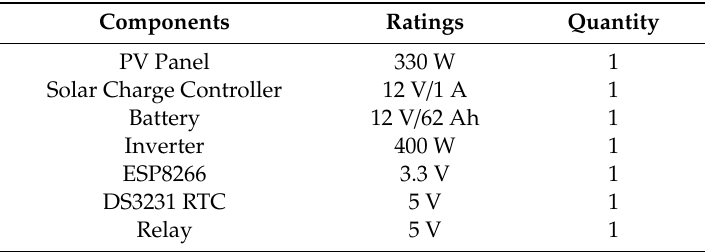
Table 3. Components specifications.